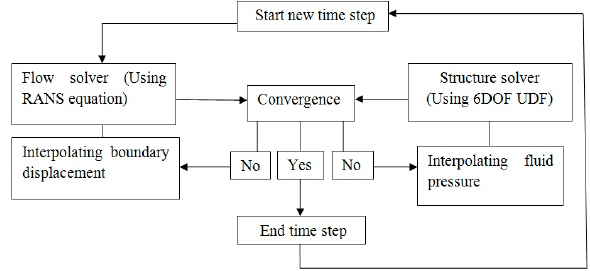
Figure 2. Flow chart of two-way implicit FSI solution procedure.